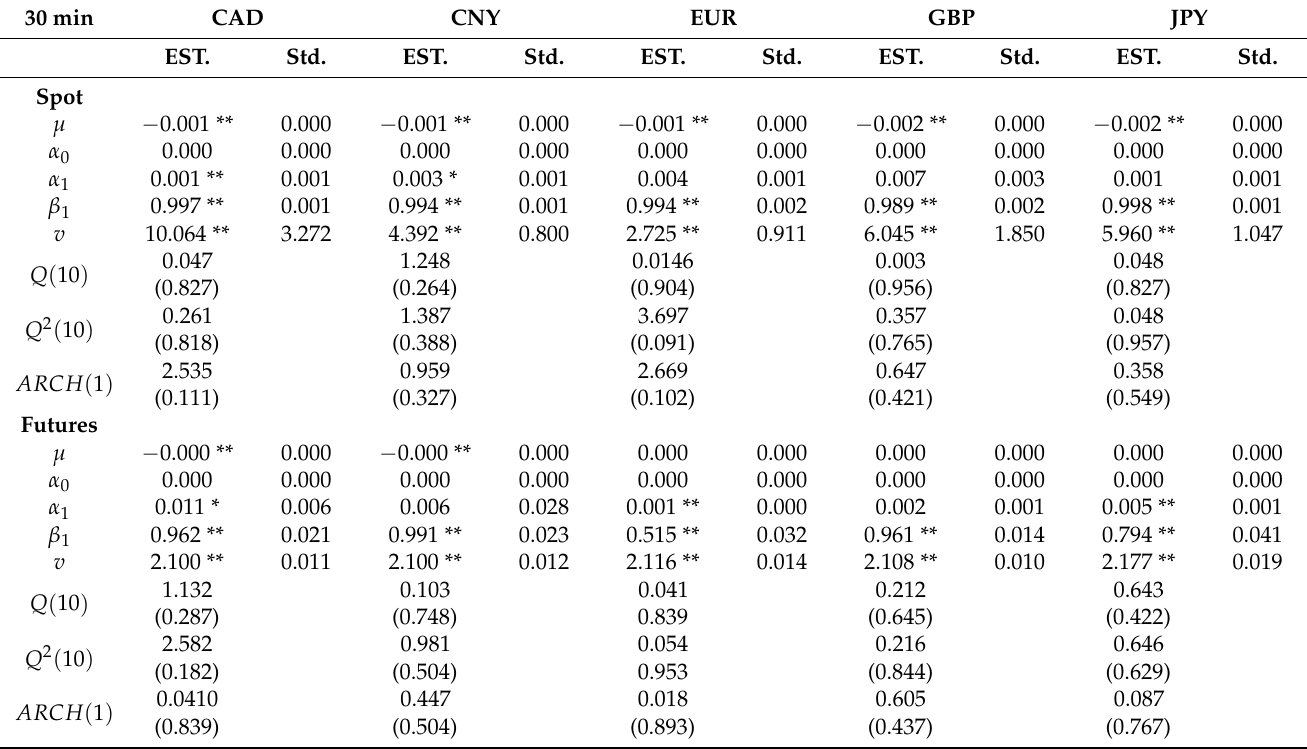
Table 4. Results from the GARCH(1,1) model estimation for 30-min spot and future